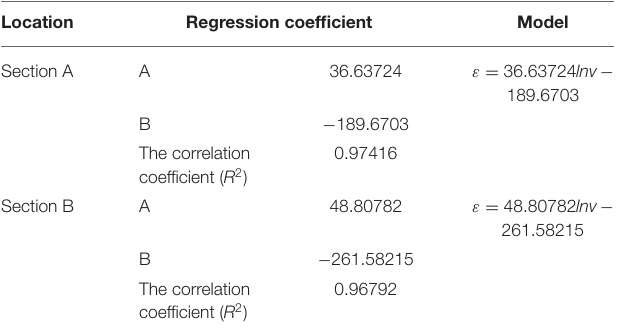
TABLE 6 | Speed and strain model. Location